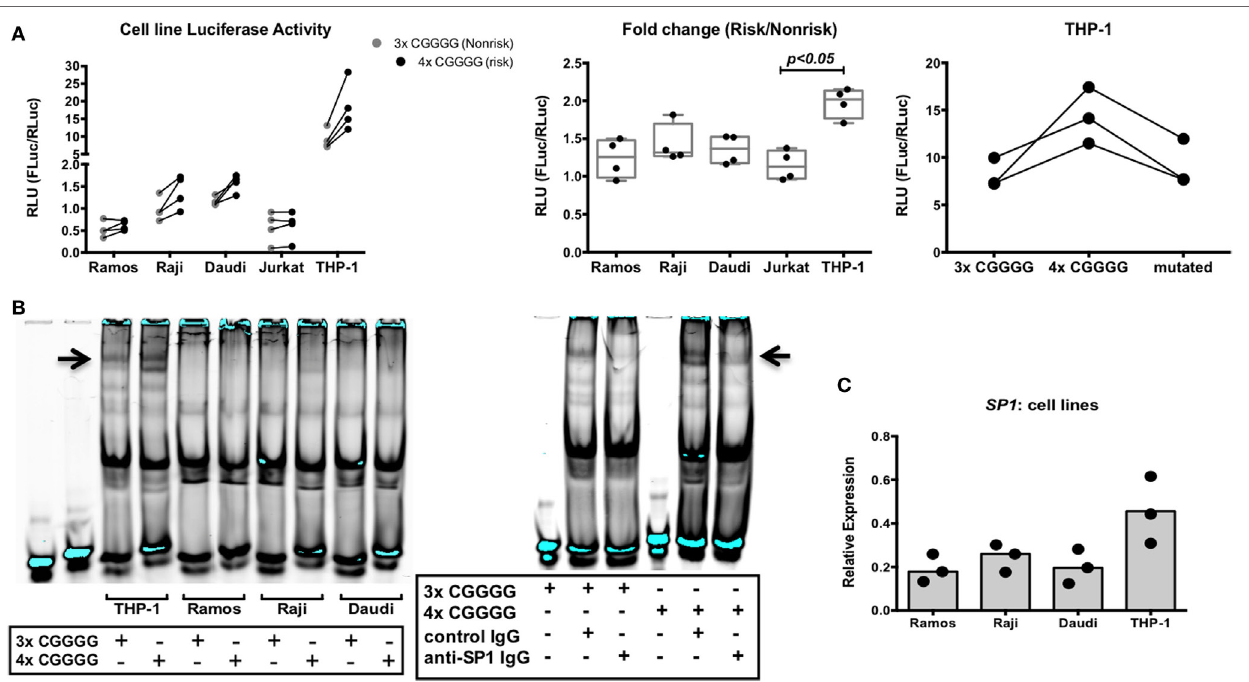
FigUre 10 | The interferon regulatory factor 5 (IRF5) promoter risk insertion/deletion (indel) results in increased IRF5 transcription and specificity protein 1 (SP1) binding in myeloid cells. (a) Normalized activities of non-risk and risk indel promoter-driven luciferase transcription in various cell lines (left), fold change in luciferase activity due to the risk indel in various cell lines (center), and risk, non-risk, and mutated promoter-driven luciferase transcription in THP-1 cells (right). Results of three or four independent experiments are shown. (B) Electrophoretic mobility shift assay showing binding to the 3 × and 4 × CGGGG indel by various nuclear extracts (left), supershift assay showing SP1 binding to the 3 × and 4 × CGGGG indel in nuclear extracts of THP-1 cells (right). Results of three independent experiments are shown. (c) SP1 mRNA levels in various cell lines. Results of three independent experiments are shown. p < 0.05 by Kruskal–Wallis test [ (a) ,